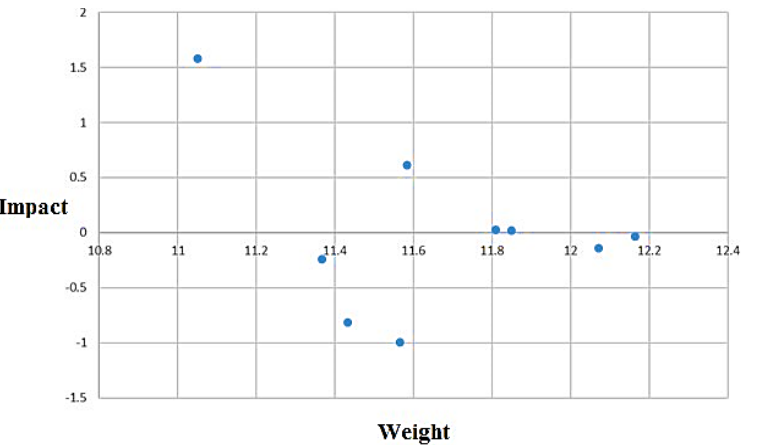
Fig. 1. The weight and interrelationship between